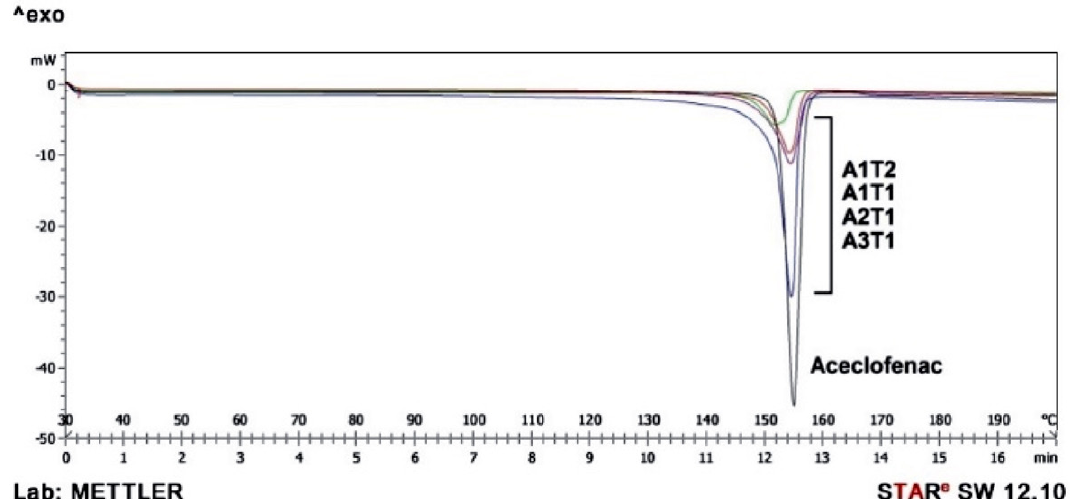
Figure 2. DSC Thermogram of aceclofenac and the